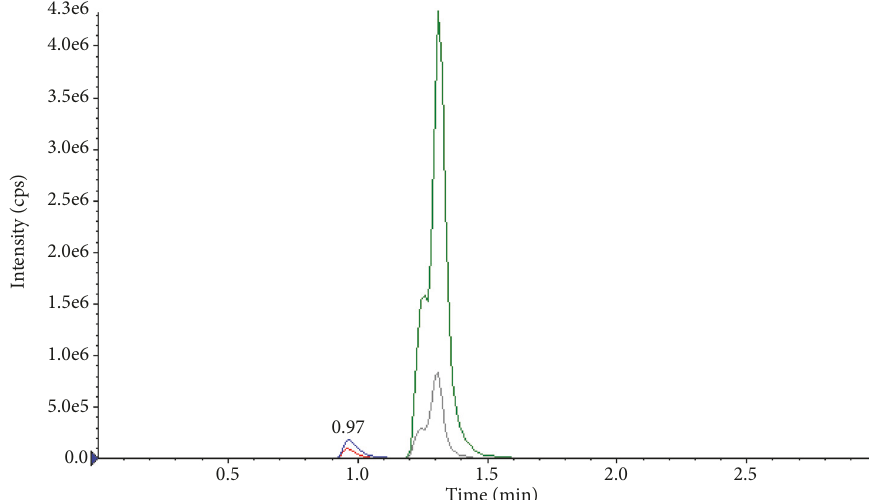
Figure 1: Chromatogram of analytes/ISTDs (LLOQ level) injected normal gemini C 18 column (50 × 4.6 mm, 5 𝜇